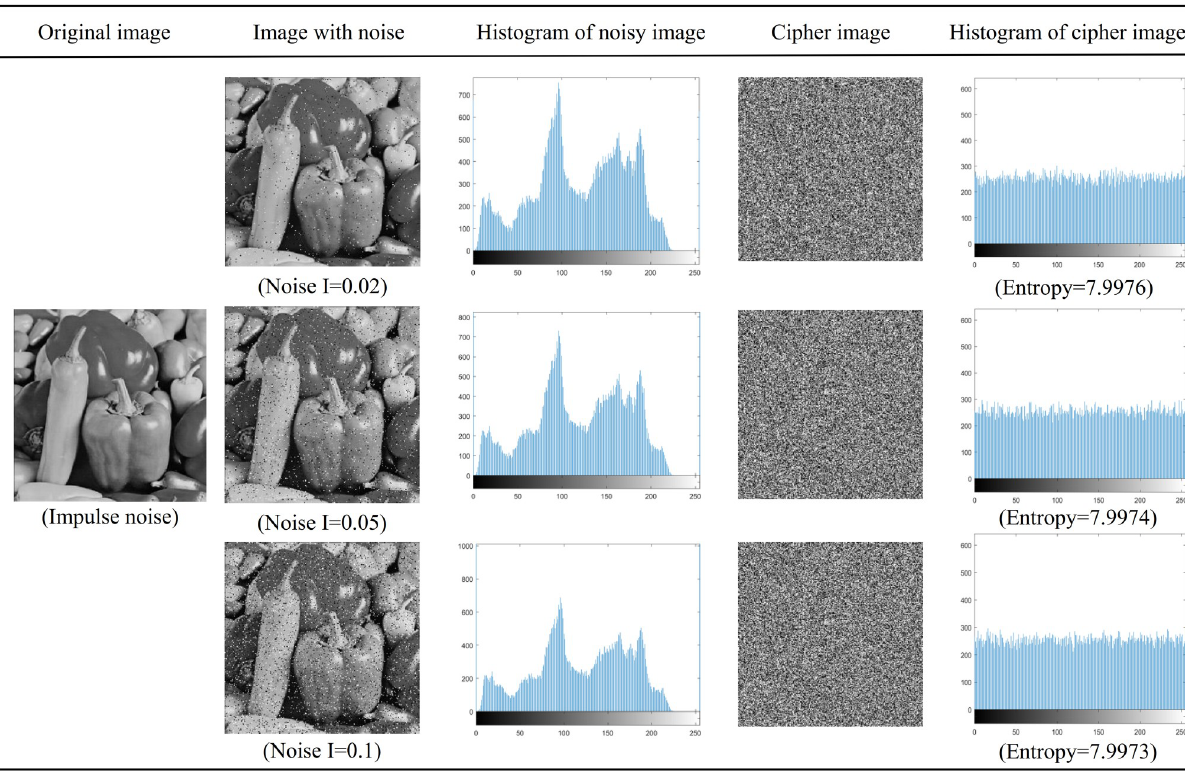
Fig 14. Histogram analysis and entropy analysis of salt-and-pepper noise image and encrypted image.